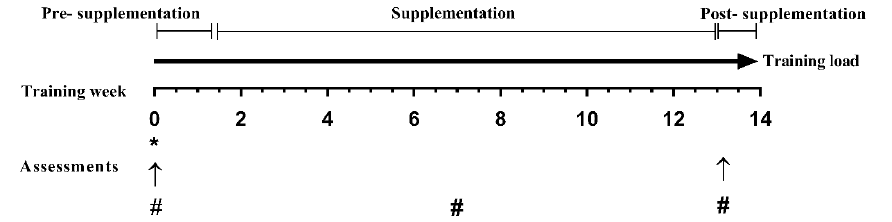
Figure 1. Study design. * Familiarisation with test procedures; ↑ Resting metabolic rate (RMR), body composition and strength and jump tests; # Food intake and venous blood sample.